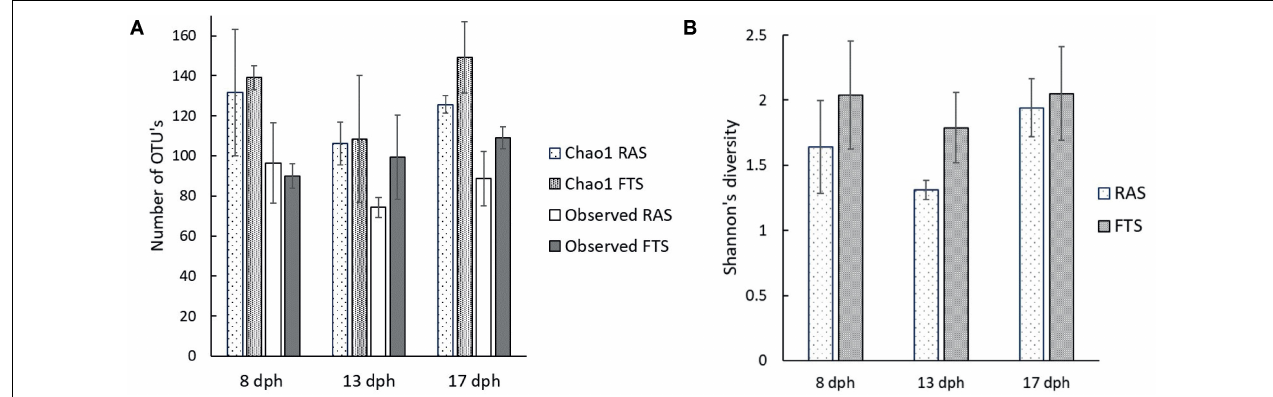
FIGURE 3 | Average richness and diversity indices for cod larval microbiota determined from amplicon pyrosequencing data based on RNA extracts from pooled cod larvae samples: 25 larvae at 8 dph, 17 larvae at 13 dph and 10 larvae at 17 dph in the RAS and FTS-LT. (A) Chao1 richness and observed number of OTU’s. (B) Shannon’s diversity